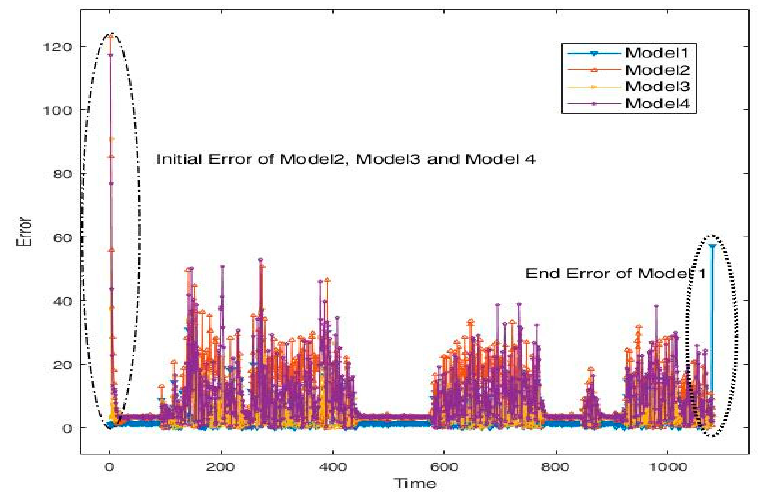
Figure 6. Comparison of predictive errors for each model in A region of Jeju Island.